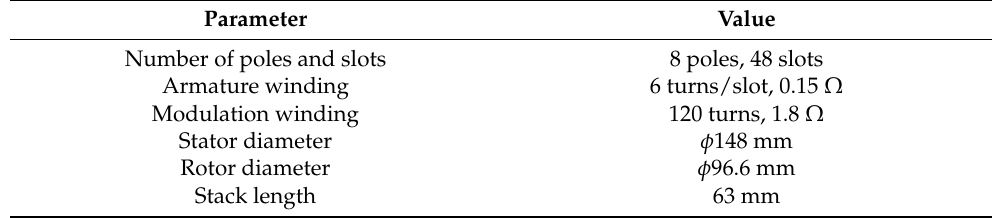
Table 1. Specifications of prototype